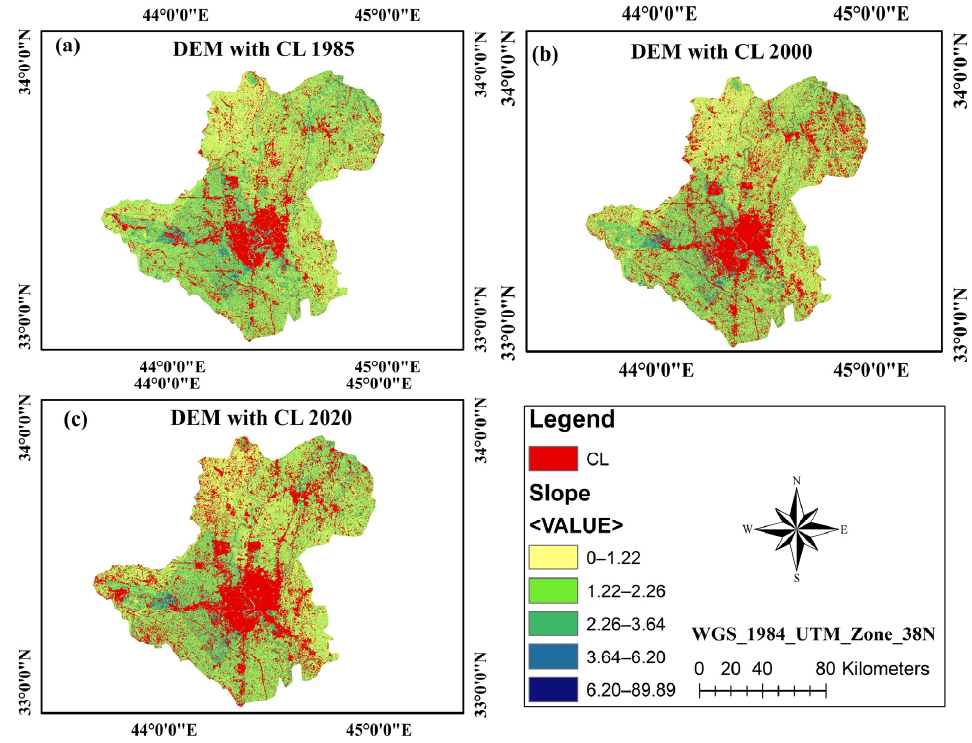
Figure 10. Influences of slope to urban CL distributed from 1985 to 2020. ( a ) slope with CL 1985, ( b ) slope with CL 2000, and ( c ) slope with CL 2020.